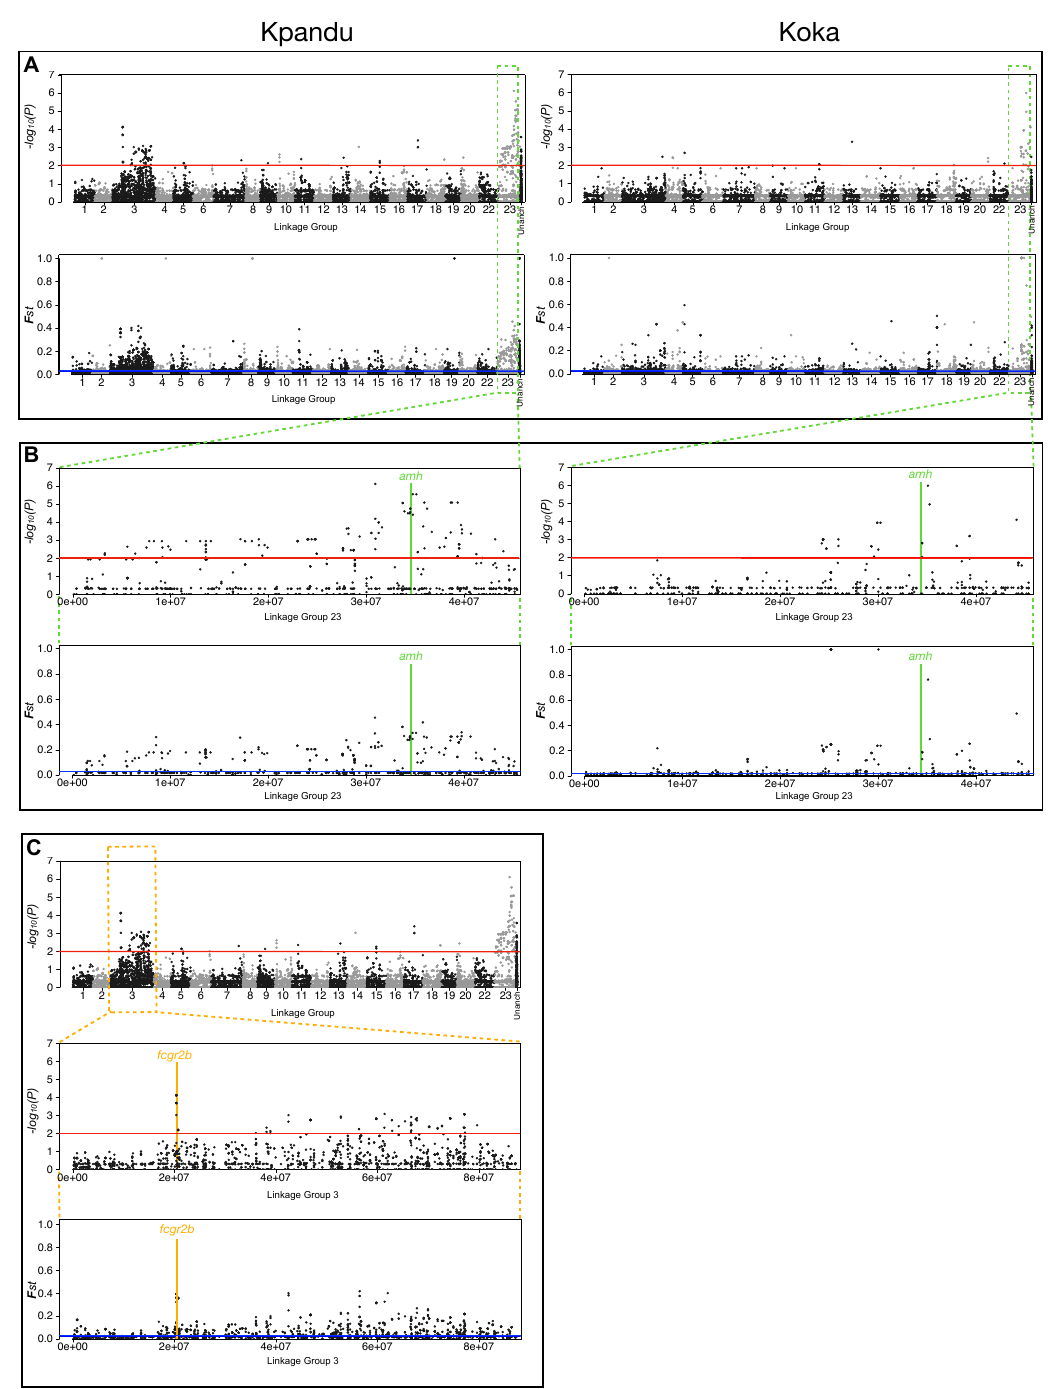
Figure 3. Manhattan plots of log10-transformed p -values from Fisher’s Exact Test (FET) and AMOVA F ST of the association of single nucleotide polymorphisms (SNPs) with phenotypic sex. ( A ) Plots for the Kpandu and the Koka families for all LGs. Unanchored contigs / sca ff olds are grouped under the label “Unanch”. ( B ) Plots for the LG23 region showing SNP sites that were associated with sex. Most of the stronger sex-signals are found between 24 and 40 Mb. ( C ) Plots for Kpandu family with a close up of the LG3 region showing a very localised signal at 20 Mb due to a RAD locus in the fcgr2b gene. The rest of the signal observed on LG3 comes from the “long arm” of the chromosome known to carry repeated elements. Red lines correspond to p -values of 0.01 in the FET plots while blue lines correspond to mean AMOVA F ST between males and females of each